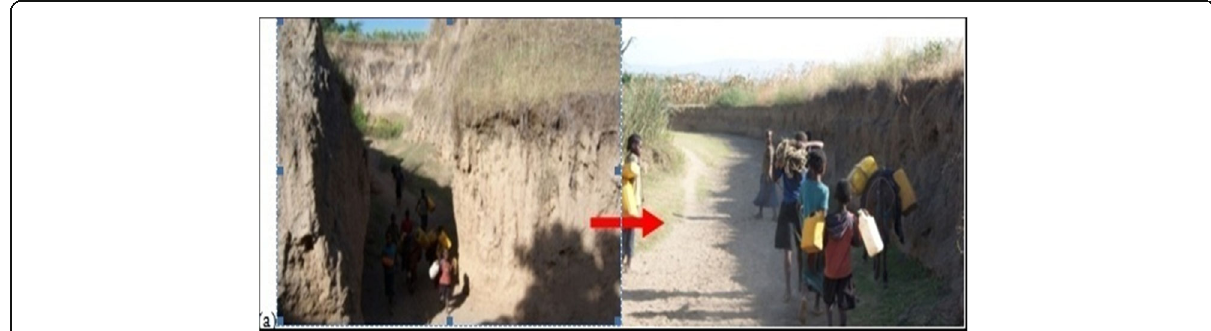
Fig. 3 Local people using the gully channel for foot way